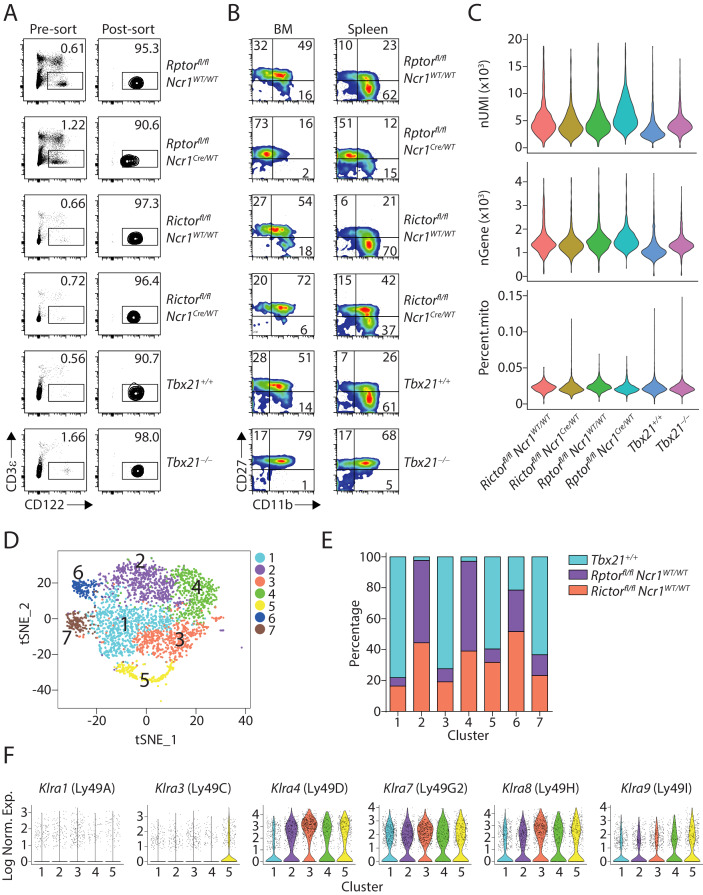
scRNA-seq analysis of CD3ε−CD122+ murine BM cells from three mutant mice and their corresponding WT mice.(A) Post-sort purity of the six samples that went through the scRNA-seq experiment. (B) The expression of CD27 and CD11b on NK cells (gated on CD3ε−NK1.1+) from BM and spleen of the six mice used in the scRNA-seq experiment. (C) nUMI, nGene and percentage of mitochondria genes in the transcriptome (percent.mito) of all cells from six samples were shown in Violin plots. (D) Seven clusters generated from the unbiased clustering analysis of NK cells from three WT mice without scaling the sample origin. (E) The composition of the three WT mice within each cluster. The input cell number from each mouse was normalized to be equal. (F) Violin plots demonstrate the expression of six Ly49 family members in each NK cluster from Figure 1C. The y-axis represents log-normalized expression value.